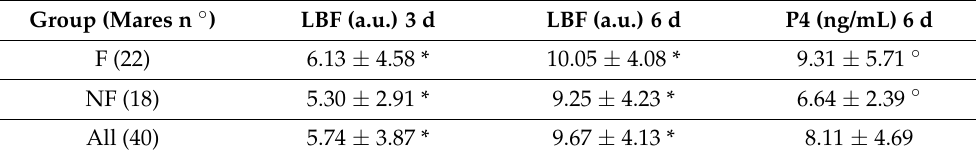
Table 1 . Differences in luteal blood flow at Days 3 and 6 and P4 levels at Day 6 in groups with and without intra-uterine fluid accumulation.